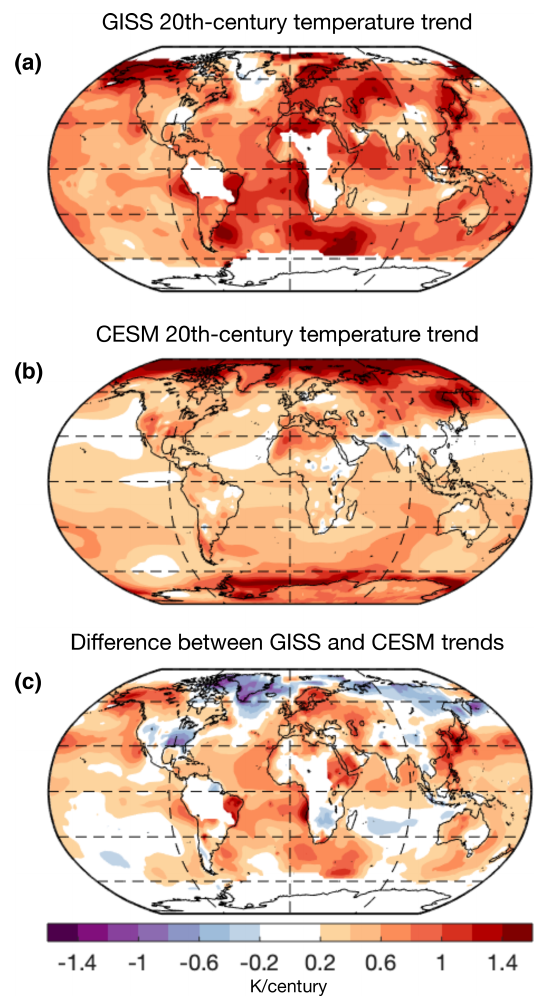
Figure A1. Linear trend in 2m air temperature (in units of K/century) between 1900–1999 in (a) the NASA GISS observa- tional dataset and (b) the CESM LME ensemble mean. (c) The dif- ference between panels (a) and (b) . Warmer temperatures are shown in red, with cooler temperatures shown in